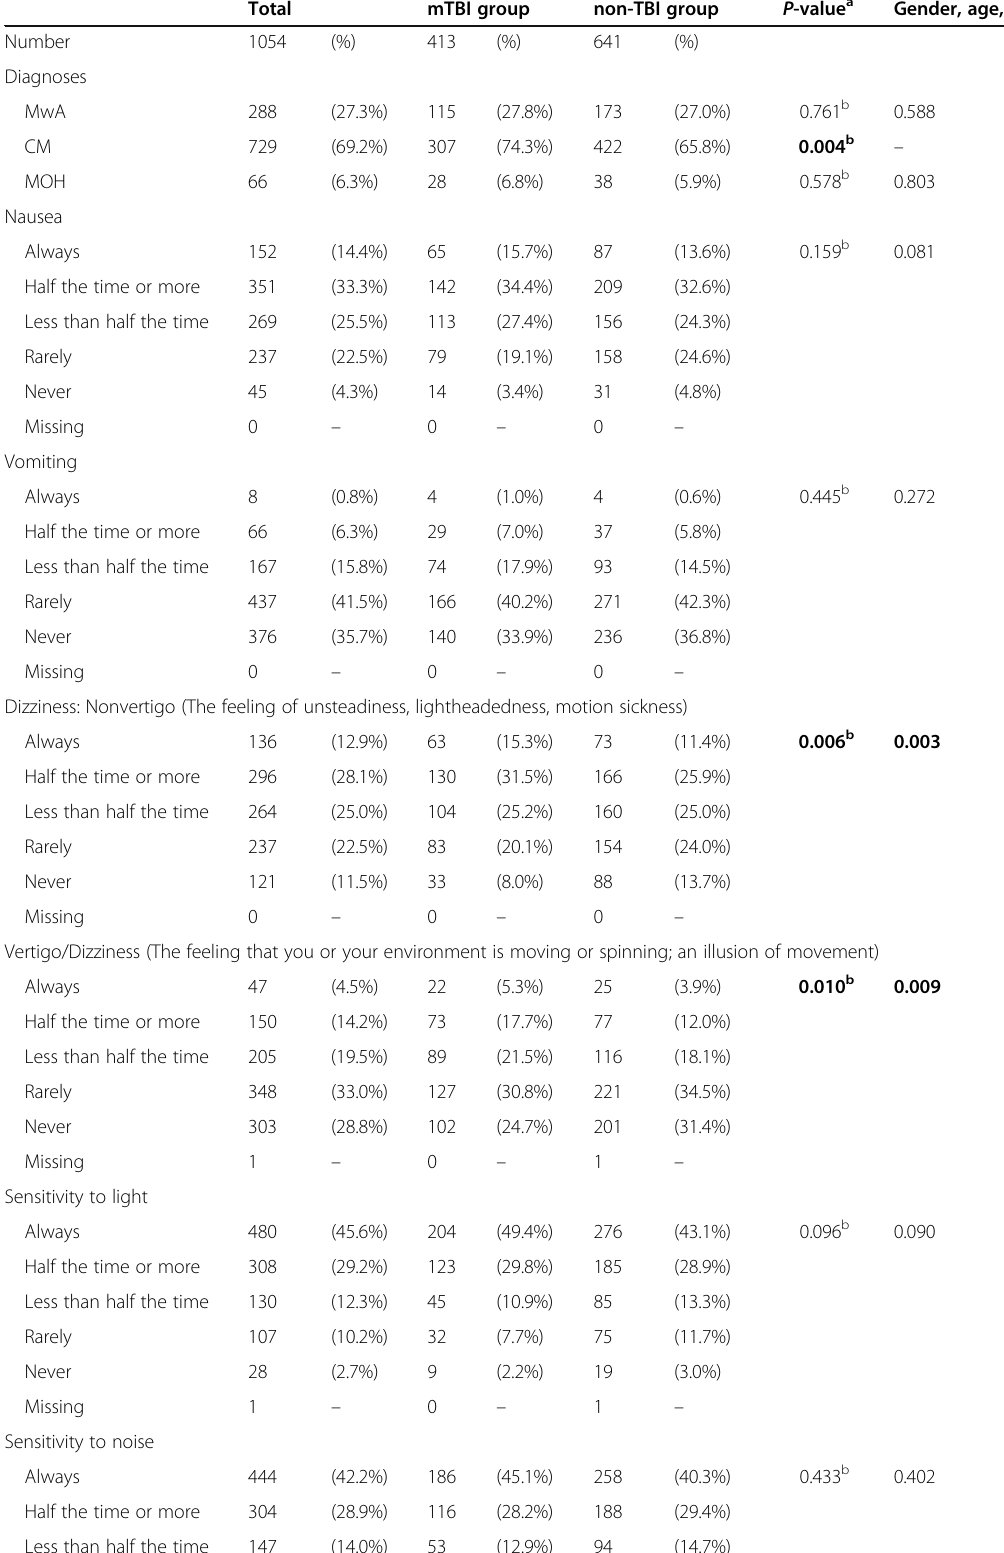
Table 3 Headache